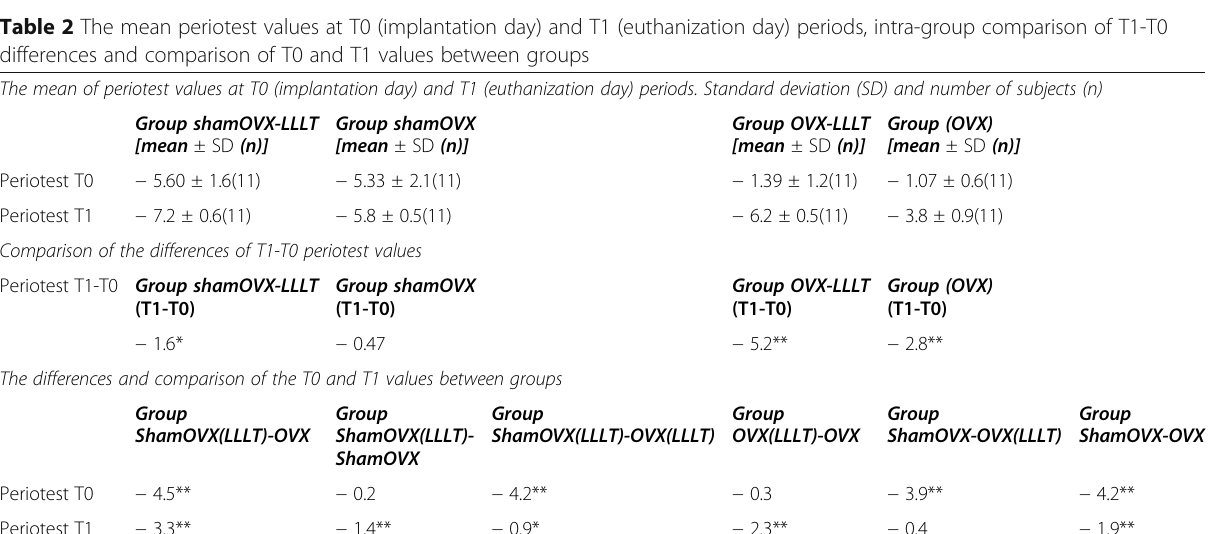
Group Group ShamOVX-OVX(LLLT) ShamOVX-OVX − 1.9**